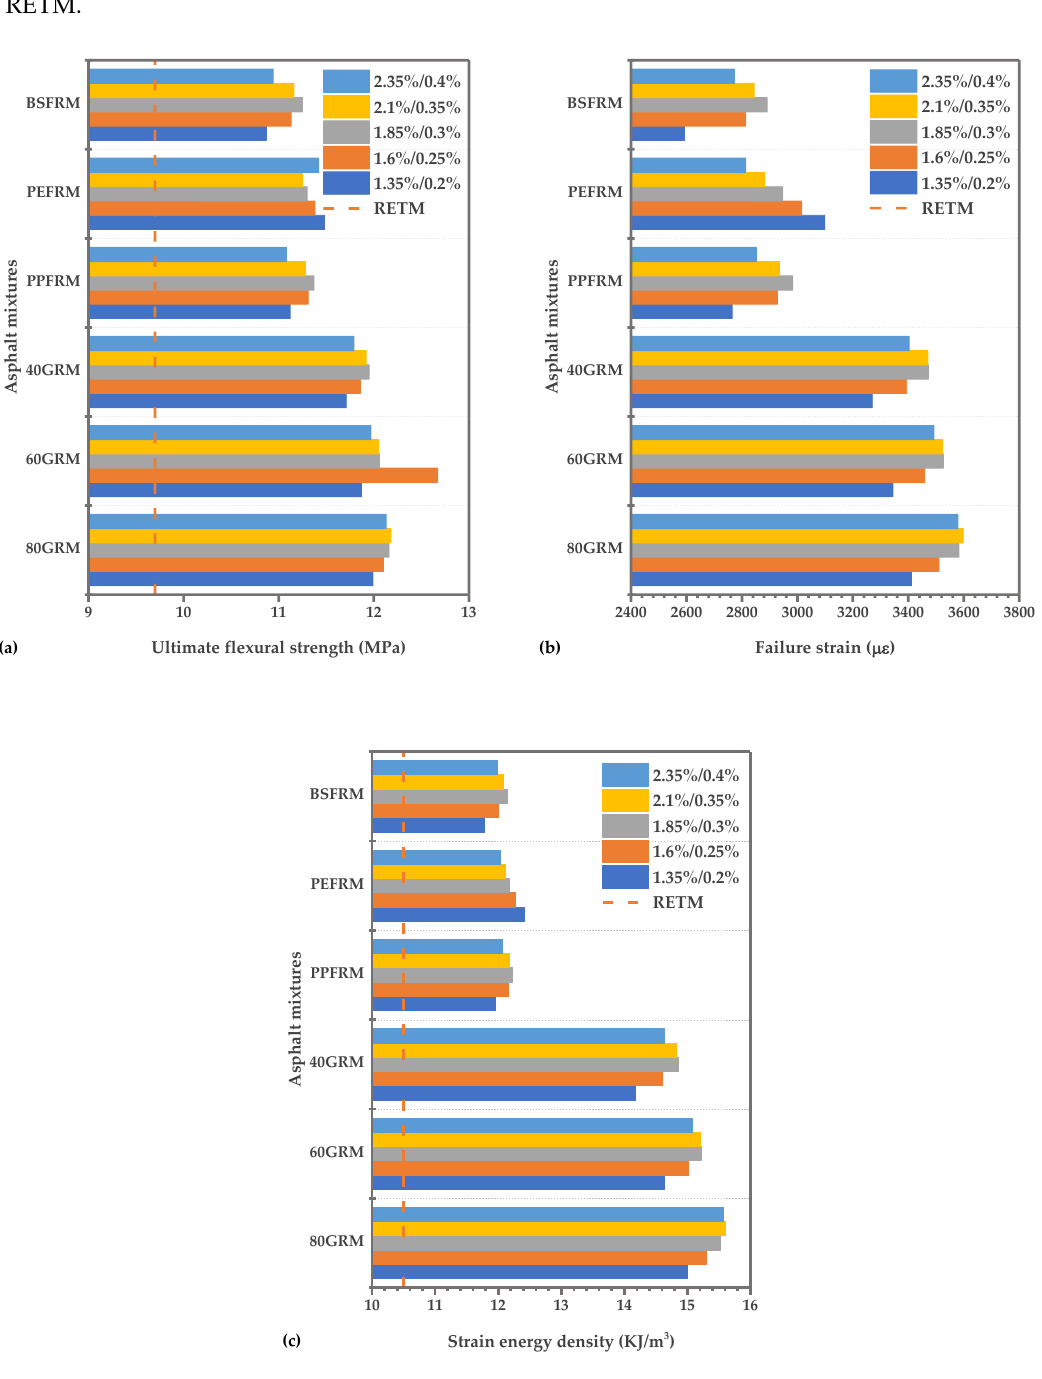
Figure 6. The beam bending test results of mixtures: ( a ) UFS, ( b ) FS, ( c ) SED.